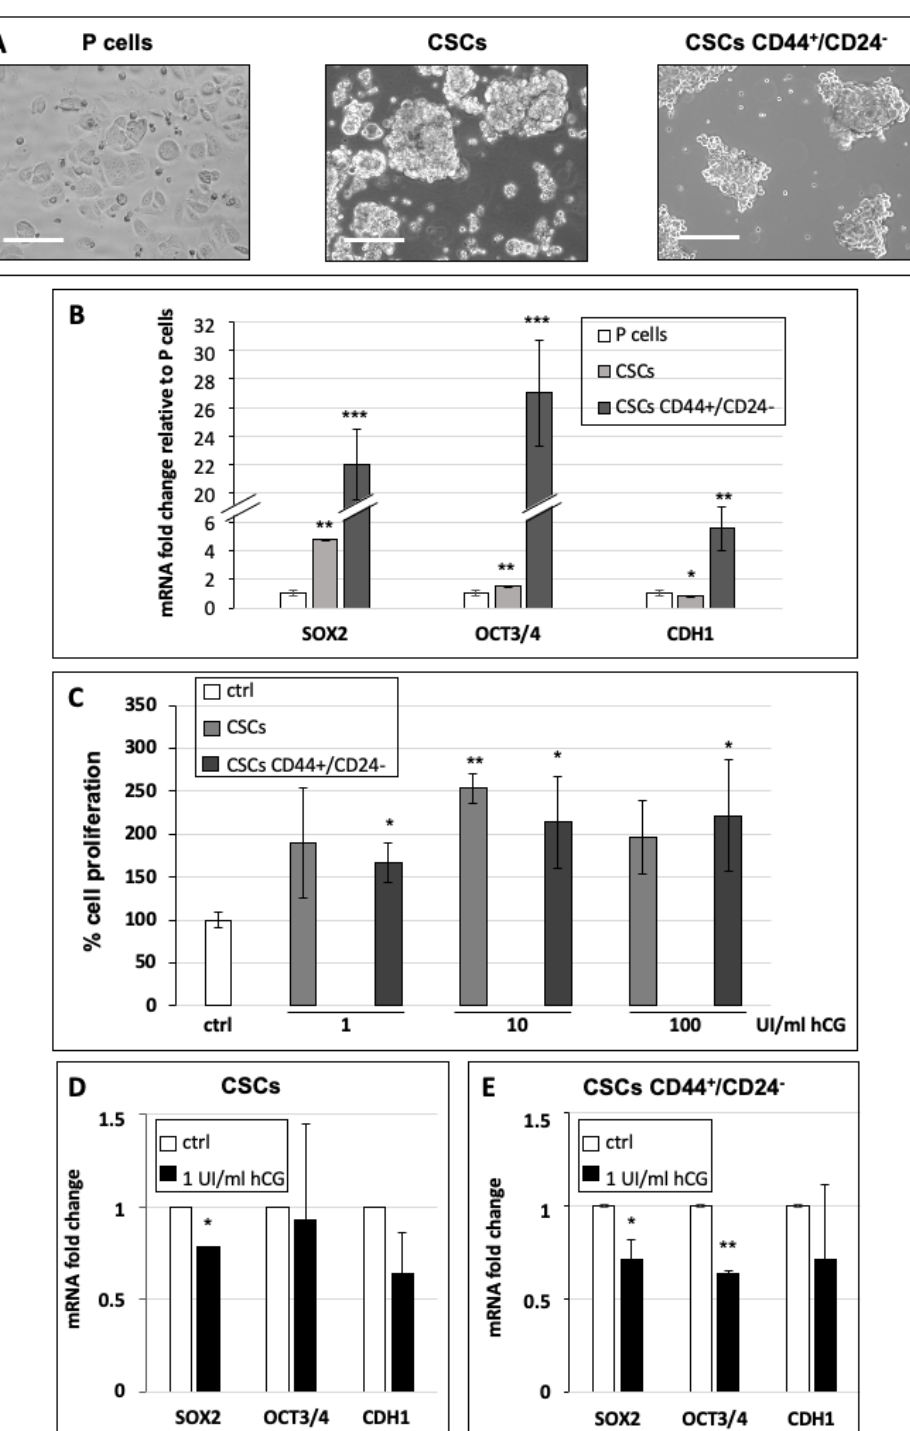
Figure 4. ( A ) Representative images of MCF7 parental (P) cells, MCF7 cancer stem cells (CSCs), and CSCs expressing CD44 + /CD24 − . Scale bar: 50 µ m. ( B ) mRNA expression levels of SOX2, OCT3/4, and CDH1 relative to the housekeeping gene expression levels (RpLp0) in MCF7 P cells (white bar), CSCs (light gray bar), and CD44 + /CD24 − CSCs (dark grey bar). ( C ) Analysis of viable CSCs after treatment with 1, 10, or 100 UI/mL hCG for 72 h. Control cells (white bar), CSCs (light gray bar), and CD44 + /CD24 − CSCs (dark grey bar). mRNA expression levels of SOX2, OCT3/4, and CDH1 relative to the housekeeping gene expression levels (RpLp0) in MCF7 CSCs ( D ) and CD44 + /CD24 − CSCs ( E ) untreated (white bar) or treated with 1 UI/mL hCG (black bar). All the experiments were performed in serum-free medium. Values are the means ( ± SD) of three independent biological replicates. Statistical legend: p < 0.5 (*), p < 0.01 (**), p < 0.001 (***) for treated cells relative to untreated cells